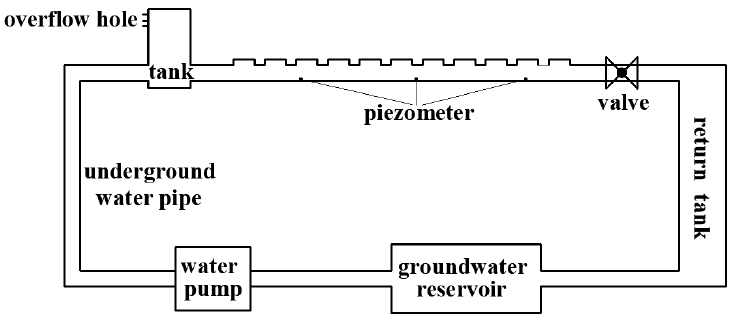
Figure 1. Schematic diagram of liquid-suspended shutdown assembly. ( a ) The normal working position; ( b ) Unprotected loss of flow accident.